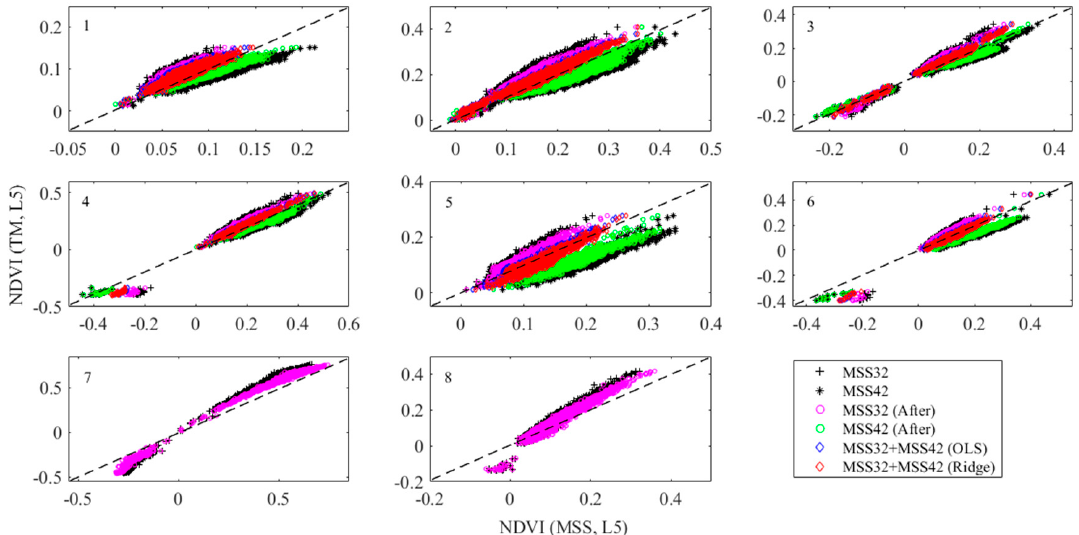
Figure 6. NDVI comparisons derived from the valid samples randomly selected for the cases (labeled as from 1 to 8) listed in Table 2. In each subplot, transformed MSS NDVI(s) as well as original MSS NDVI(s) are shown with comparison to TM NDVI. For cases 7 and 8, only MSS32 NDVI is shown, due mainly to the data problem of the MSS NIR2 imagery. The dashed lines are 1:1 lines superimposed for reference.